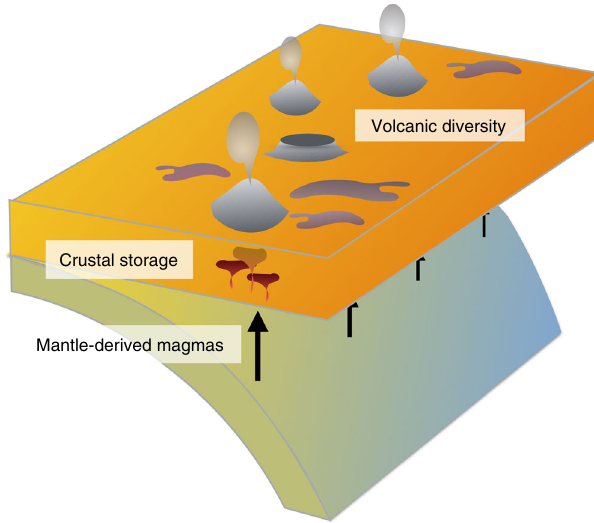
Fig. 2 Schematic fi gure of the possible mantle and crustal roles in forming arc volcanic diversity. Mantle-derived magmas are input into the crust, where they are stored, crystallize, and trigger crustal melting, which in some combination produces the variation in eruptive behavior (eruptive style, composition, and fl ux) observed along striking a volcanic